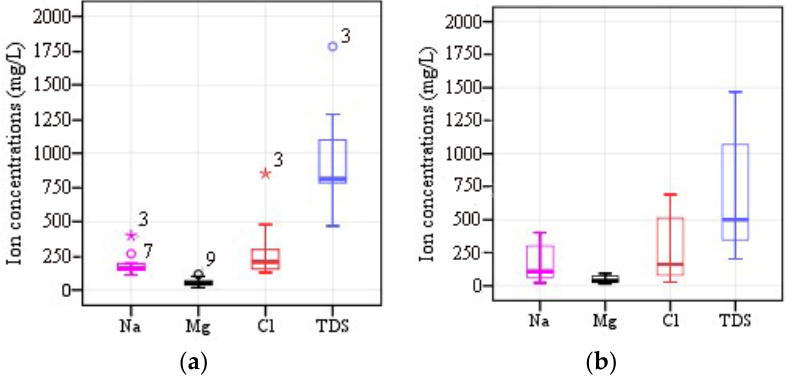
Figure 6. Box line diagram of major ions concentrations of groundwater ( a ) and lake water ( b ). (Since there is little difference in the other ion concentrations between the groundwater and lake water, only Na, Mg, Cl, and TDS data are selected for plotting.)